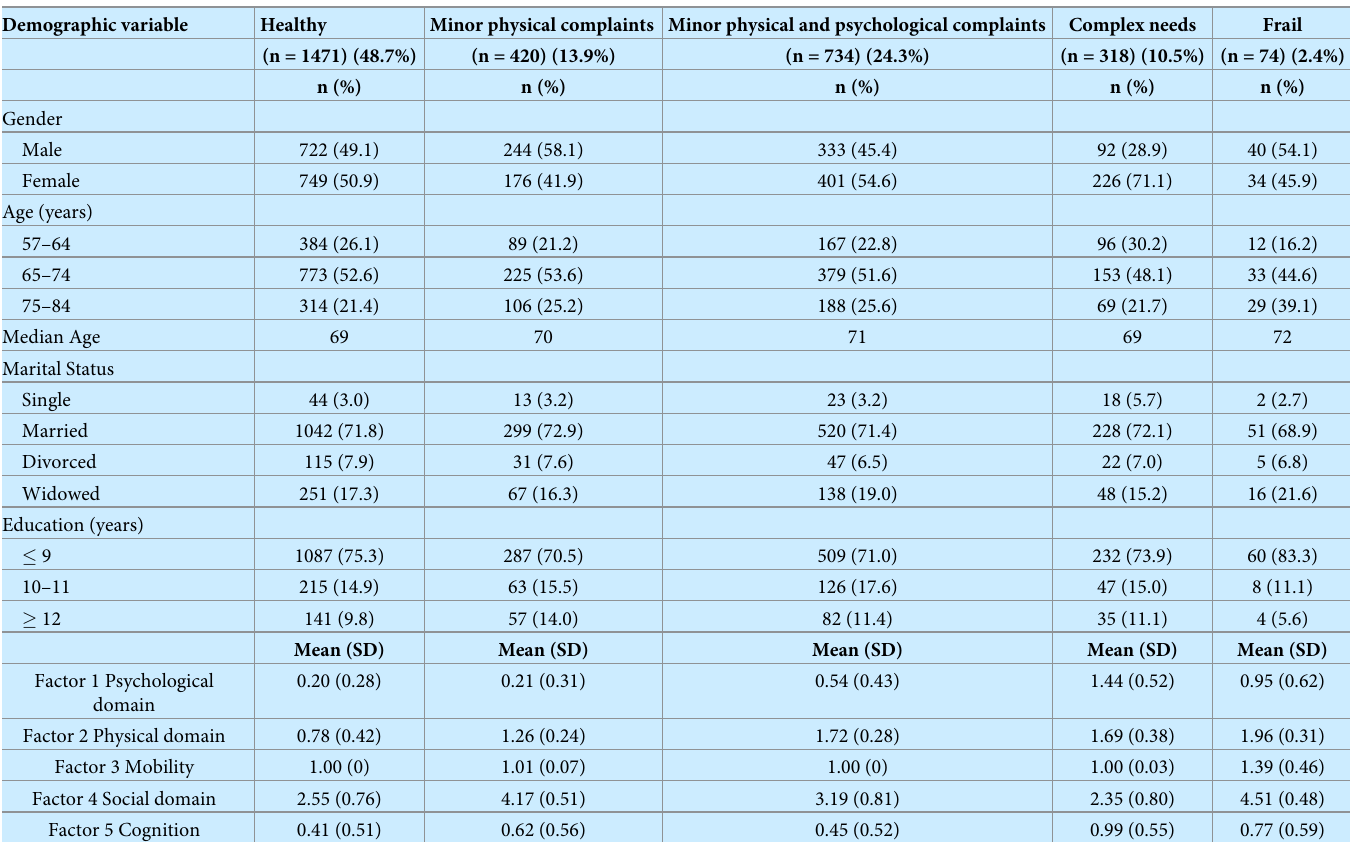
Table 1. Demographic characteristics of the five clusters of elderly